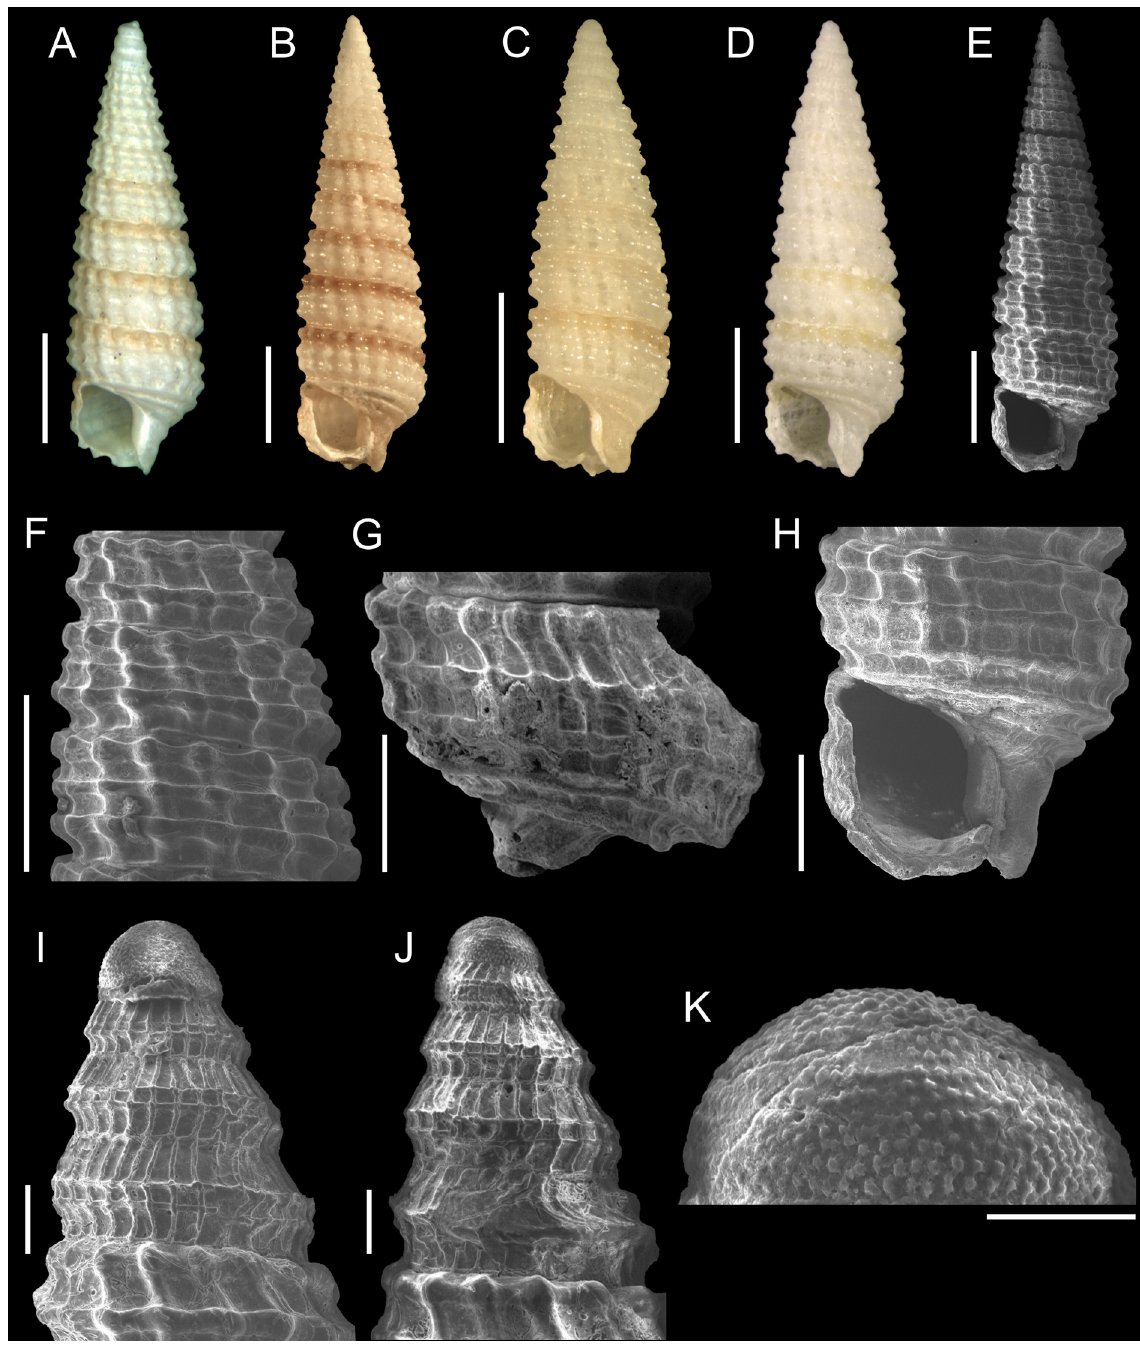
Fig. 17. Similiphora lucida sp. nov. A . MZSP 92075, holotype, 4.14 mm. B . MNRJ 29396*, 4.73 mm. C . MNRJ 31603*, 2.84 mm. D . MNRJ 31602*, 3.97 mm. E–H . Same shell as B. I–K . Same shell as C. Scale bars: A–E = 1 mm; F–H = 500 µm; I–J = 100 µm; K = 50 µm . Photo credits A: Daniel Abbate